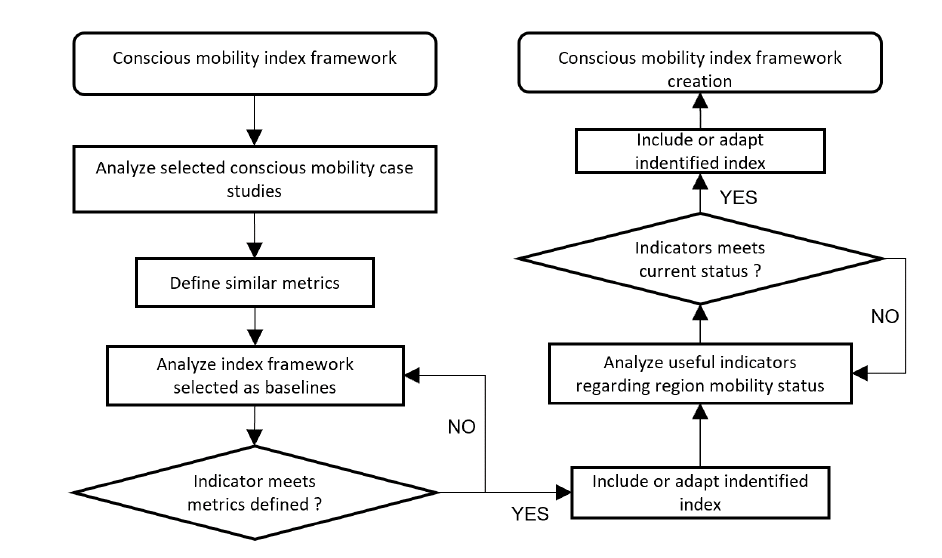
Figure 4. Flow diagram for the construction of conscious mobility indicators